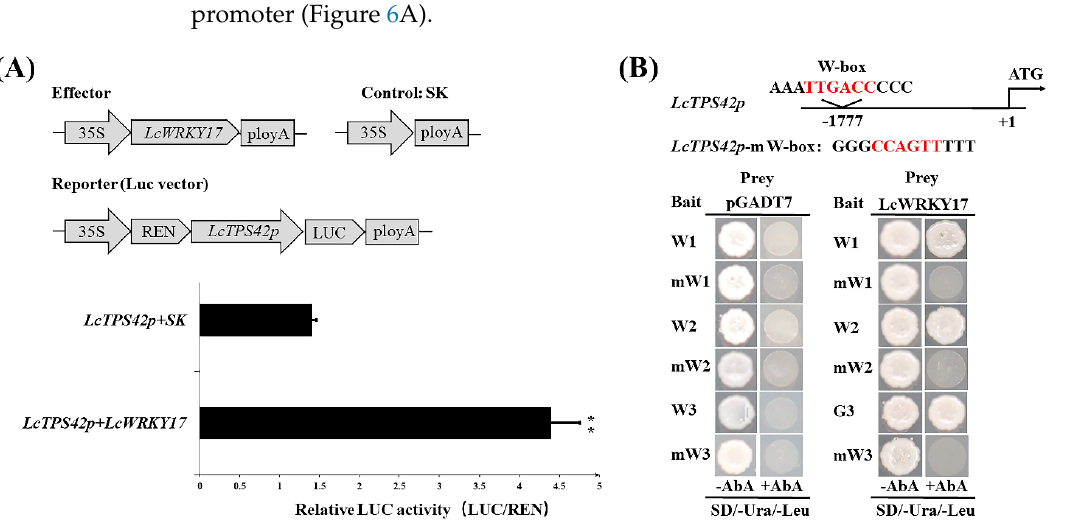
Figure 6. LcWRKY17 binds directly to the LcTPS42 promoter element. ( A ) Dual-LUC analysis showed that LcWRKY17 activated the LcTPS42 promoter (**, p < 0.01). ( B ) Y1H analysis showed that LcWRKY17 binds to the W-box elements of the LcTPS42 promoter. Red font indicates the sequence of W-box element and the sequence of mutant element We used the Y1H assay to advance our understanding of the LcWRKY17 transcription factor’s regulatory mechanism on the LcTPS42 promoter. Y1H assay revealed that co- transformation of three tandem repeats of the W-box element and pGADT7- LcWRKY17 Aureobasidin A (AbA) antibiotic plates, while mutant W-box (m W-box) element and pGADT7- LcWRKY17 co-transformation could not grow on plates containing AbA antibiotics (Figure 6B). The results suggested that LcWRKY17 binds to the W-box motif of the LcTPS42 promoter. Thus, LcWRKY17 regulates the synthesis of monoterpenoids by binding to the W-box elements of the LcTPS42 promoter.